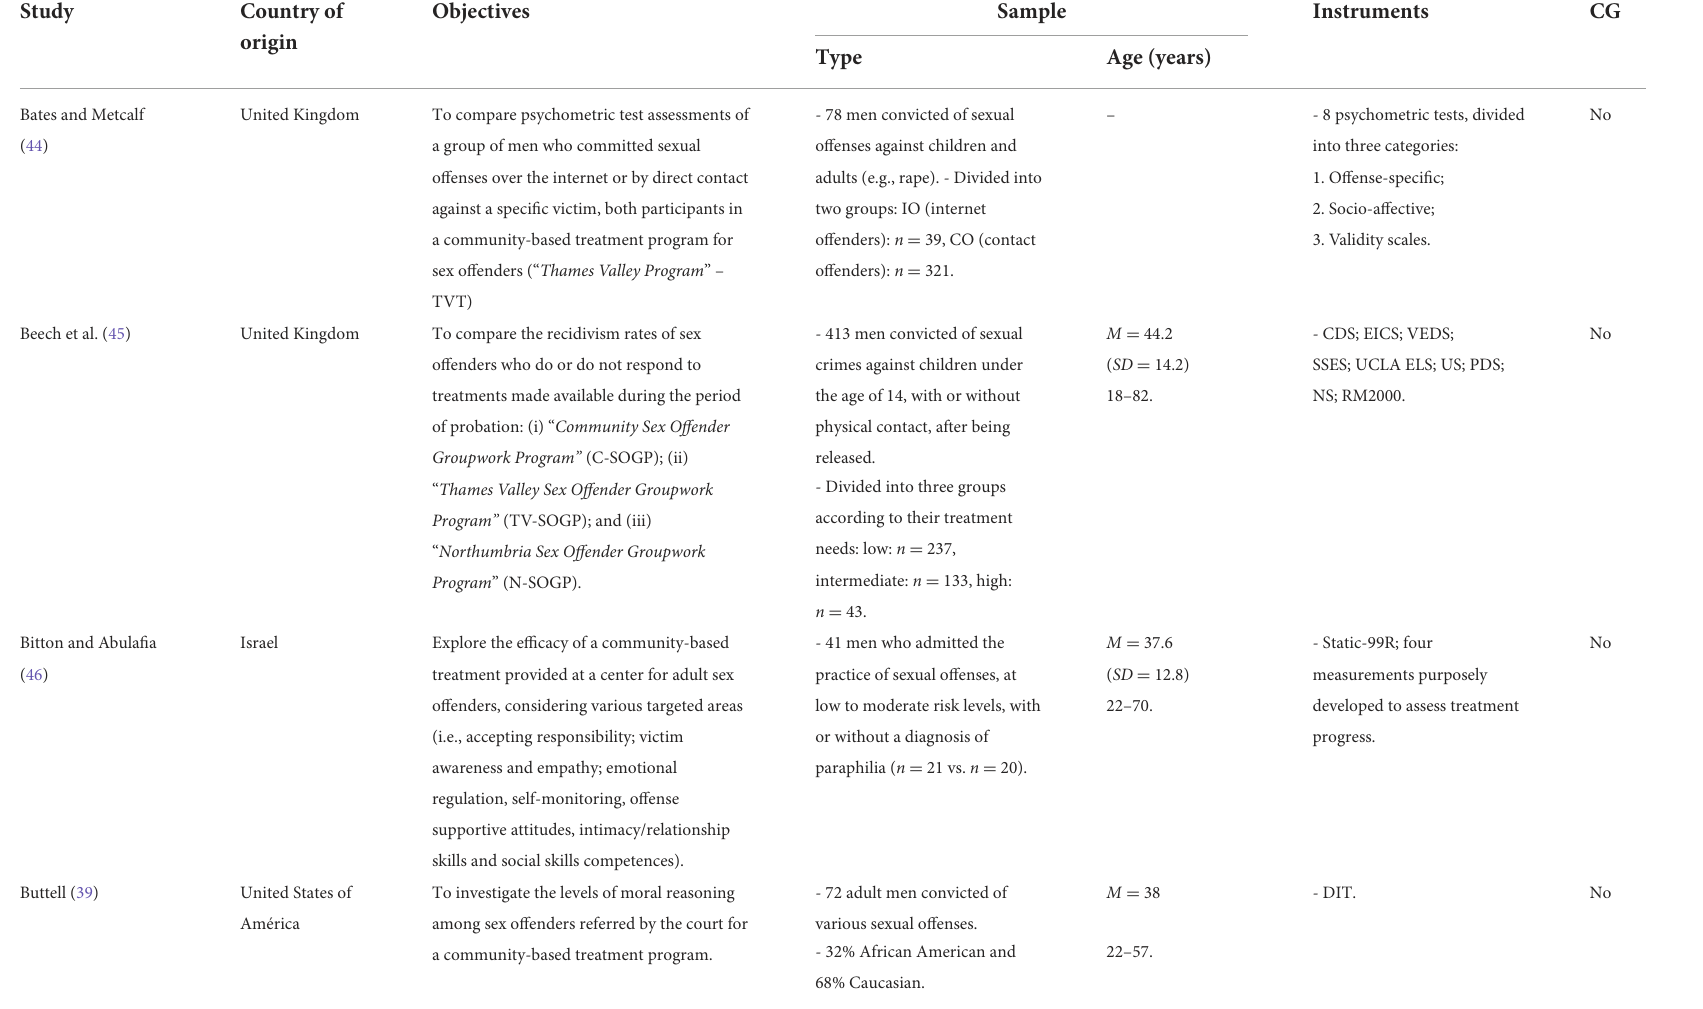
TABLE 2 Studies’